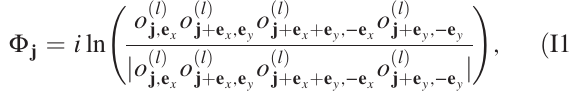
FIG. 9. (Quasi-) BR distribution calculated using three different methods to determine the bands connectivity. The methods are (from left to right for each entry) (i) standard method of topological quantum chemistry which neglects connections away from high-symmetry points, (ii) taking into account the con- nections away from high-symmetry points which are predicted by the parity compatibility relation, and (iii) looking for π defects in the Berry flux. This method is able to detect all connections (if a fine enough grid is used). The column top1 and top2 refer to the two fragile topological phases discovered by our NN; cf. Fig. 3 of the main text. The standard method would predict other types of topological bands (top. el.). These sets of bands turn out not to be isolated once the connections away from the high-symmetry points are taken into account with the other two methods. All results are calculated using the first six bands. The set of bands that is connected to the seventh band can not be assigned to any (quasi-) BR based on the available information and is grouped in the last entry [tba (to be assigned)].